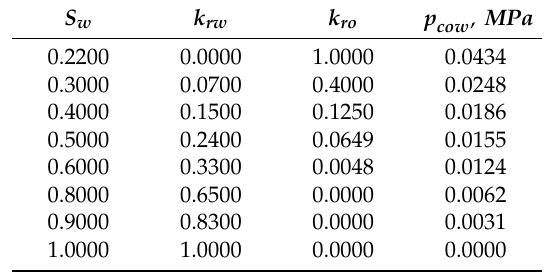
Table 8. Relative permeabilities and capillary pressures used in the case.